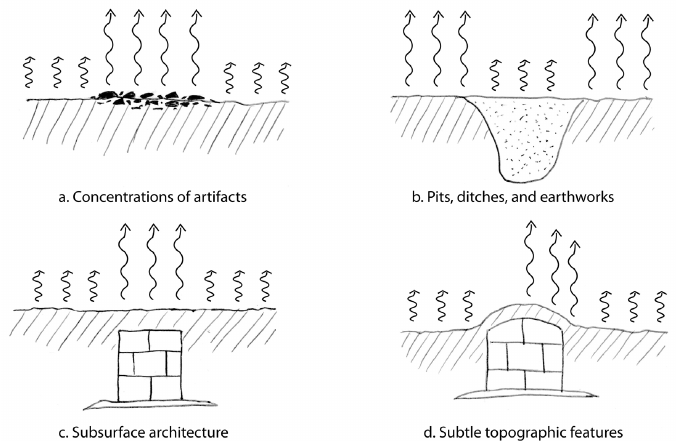
Figure 1. Thermal image identification of archaeological elements, introduced by the authors in [10].